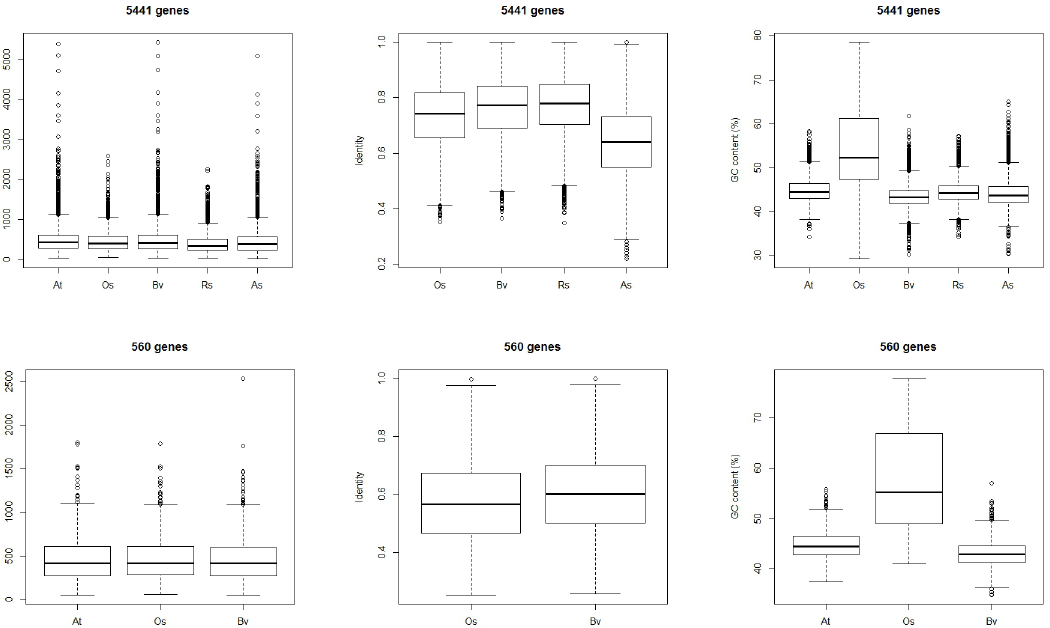
Fig 3. Characteristics of the conserved (5441 genes) and lost (560 genes) gene sets common to both R . soongorica and sand rice. At, A . thaliana ; Os, O . sativa ; Bv, B . vulgaris ; Rs, R . soongorica ; As, A . squarrosum .